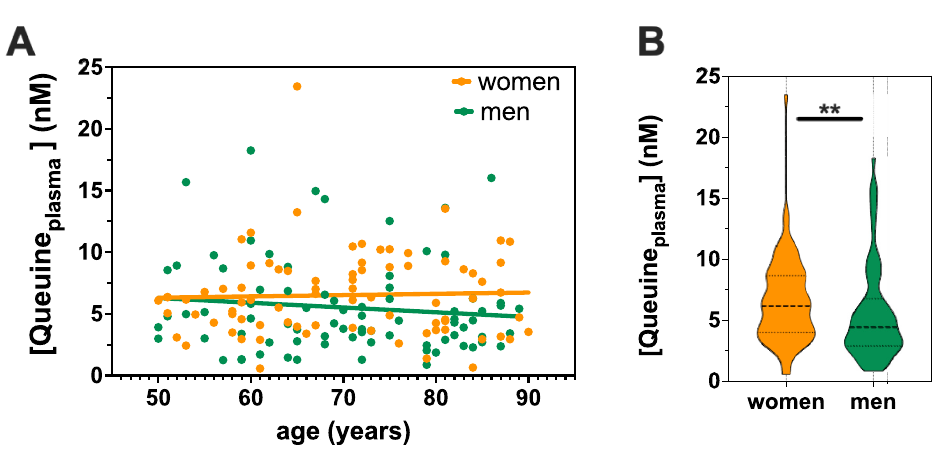
Fig 4. Queuine level in plasma does not vary with age but is higher in women than men. (A) Measurement of queuine level was performed by LC-MS/MS in plasma samples of 80 neurologically healthy women and 80 neurologically healthy men from 50 to 90 years old. (B) Comparison of queuine level between men and women as shown in A. �� p < 0.01 (Mann Whitney